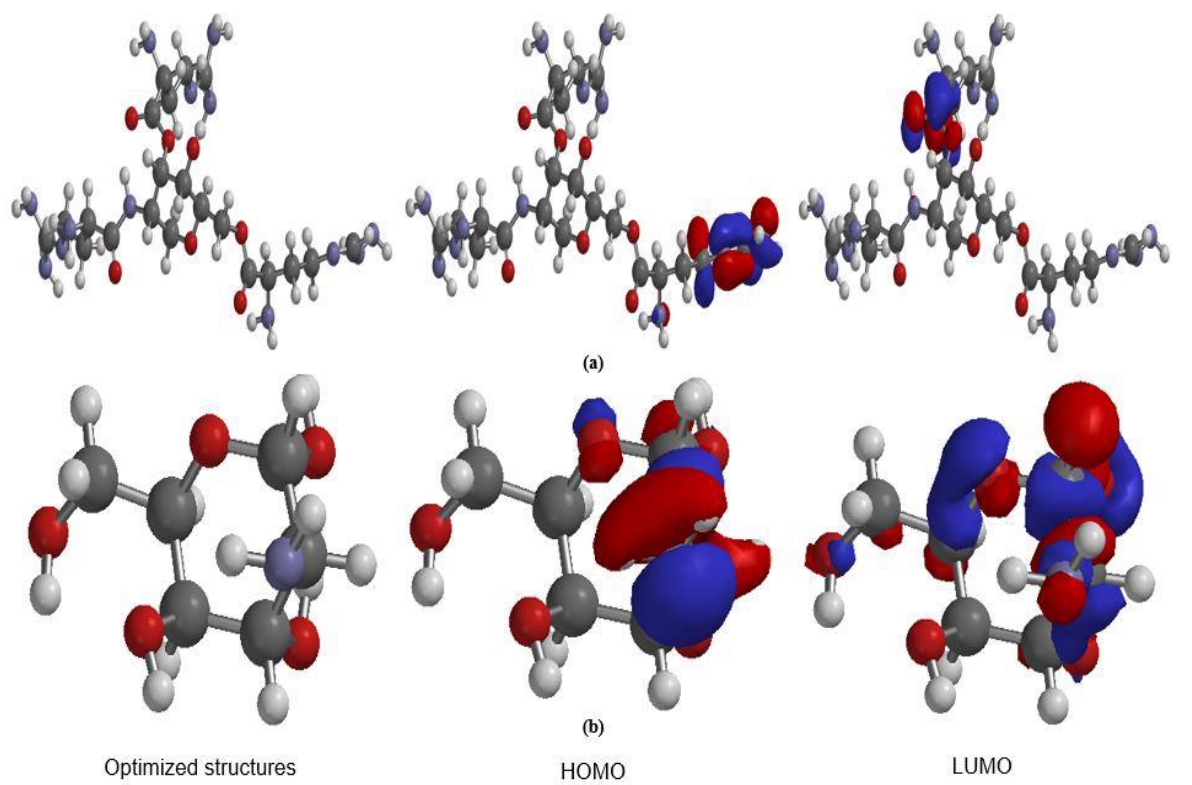
Figure 7. Optimized structures and frontier molecular orbitals electron density distribution (HOMO and LUMO) of: ( a ) Cs-g-L-arginine and ( b ) chitosan. Table 3. Quantum Chemical Parameters.